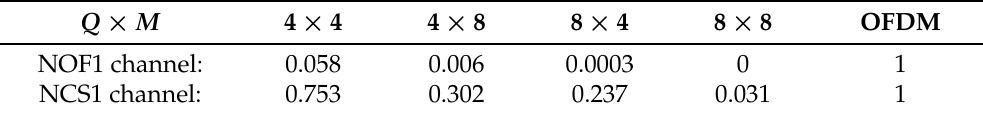
Table 2. Packet error rate at an SNR of 3